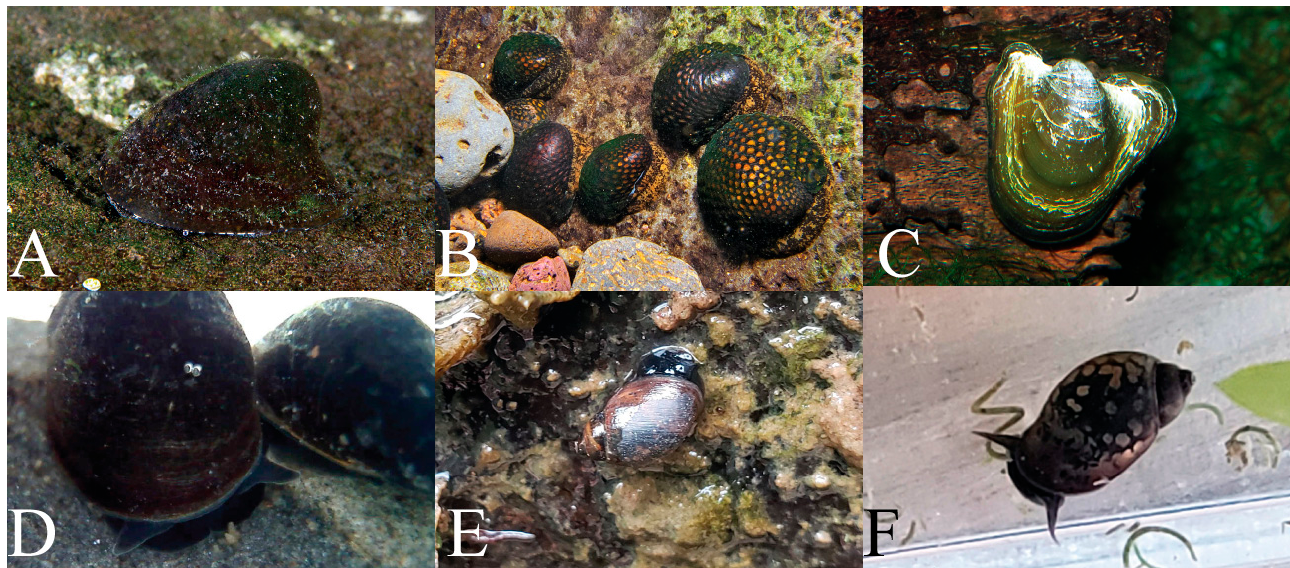
Figure 1. Live representatives of Hawaii’s endemic freshwater snail fauna. ( A ) Neripteron cariosum (Wood, 1828), ( B ) Neritona granosa (Sowerby, 1825), ( C ) and Neripteron vespertinum (Sowerby, 1849), ( D ) Erinna newcombi H. Adams and A. Adams in A. Adams, 1855, ( E , F ) Pseudosidora c.f. producta (Mighels, 1845) in its natural seep habitat ( E ) and in artificial habitat in the laboratory ( F ). Photo credits: ( A – C ) Keoki Stender, ( D ) Gordon Smith, U.S. Fish and Wildlife Service, and ( E , F ) Kenneth Hayes.